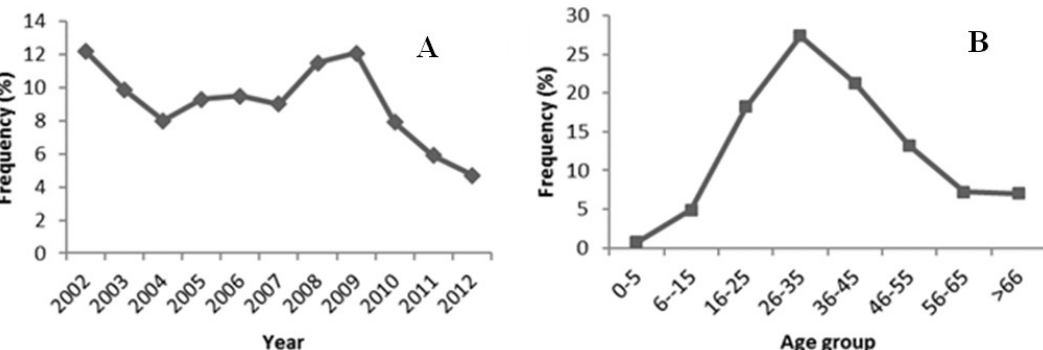
Figure 1. Frequency (%) of the samples by year ( A ) and age group ( B ) during the study period.